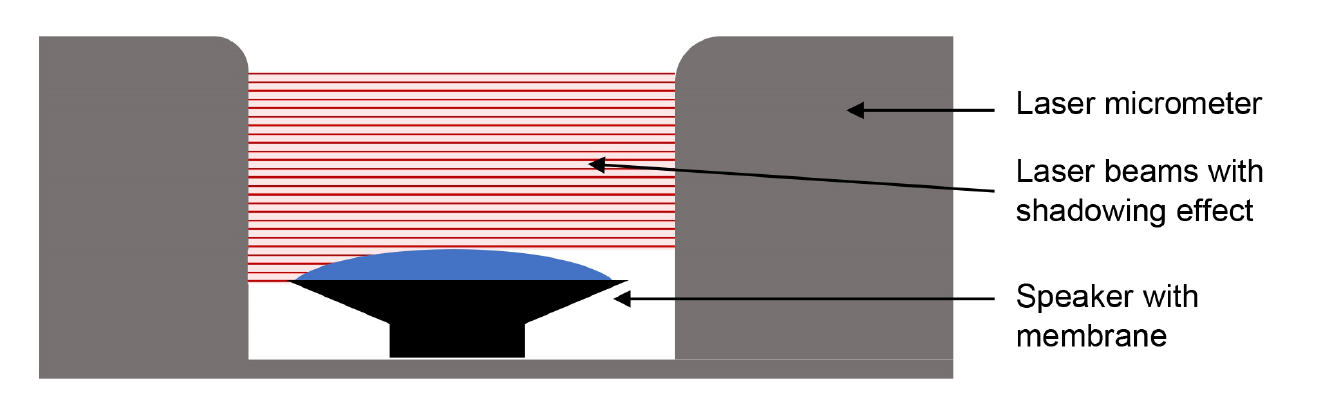
Figure 1. Electro-mechanical approach for the neonatal simulator. Whenever the membrane of the speaker moves and penetrates the light carpet the change can be